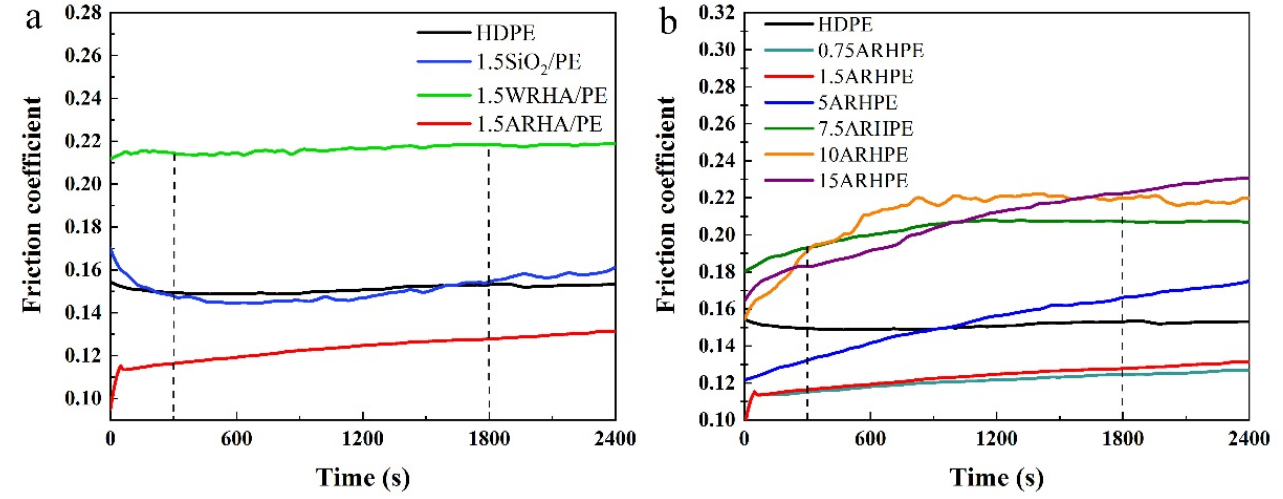
Figure 9. The friction coefficient of ( a ) pure HDPE and its composites with the three kinds of fillers and ( b ) pure HDPE and ARHA/PE composites with various filler loadings with a load of 45 N.